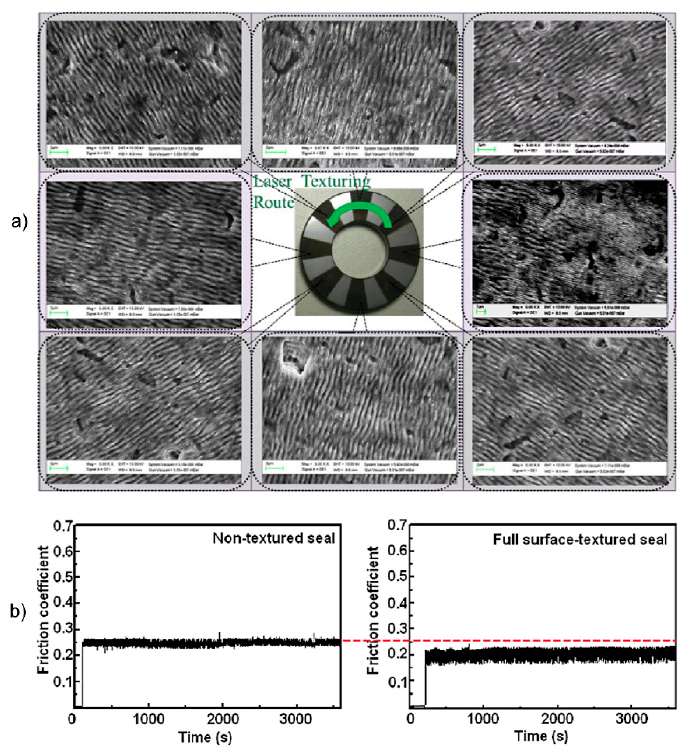
Figure 21. Friction properties of SiC mechanical seals: ( a ) SEM micrographs of the surface and ( b ) friction coefficient of the unstructured ( left ) and full-textured seal ( right ). Adapted from Chen et al. [148], with permission of Springer.